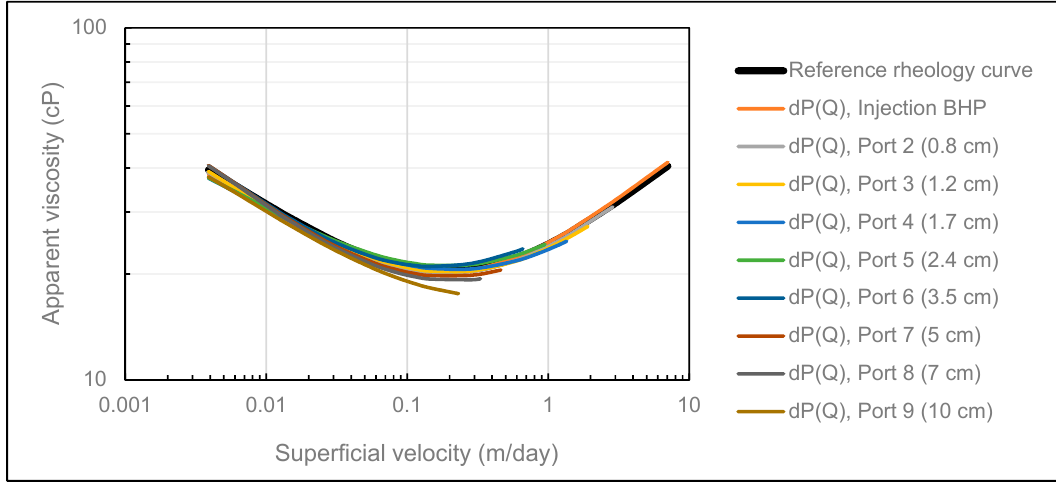
Figure 6. Comparison of the reference rheology curve (black) and rheology curves obtained in CMOST after influence of typical pressure measurement error using the SPMM.